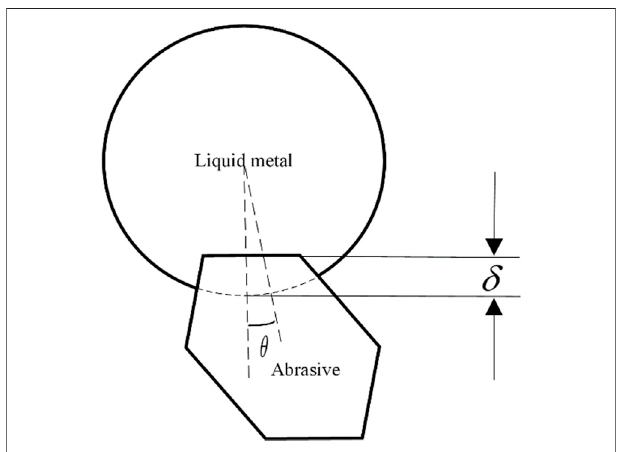
FIGURE 3 | Schematic of normal superposition in the soft collision.